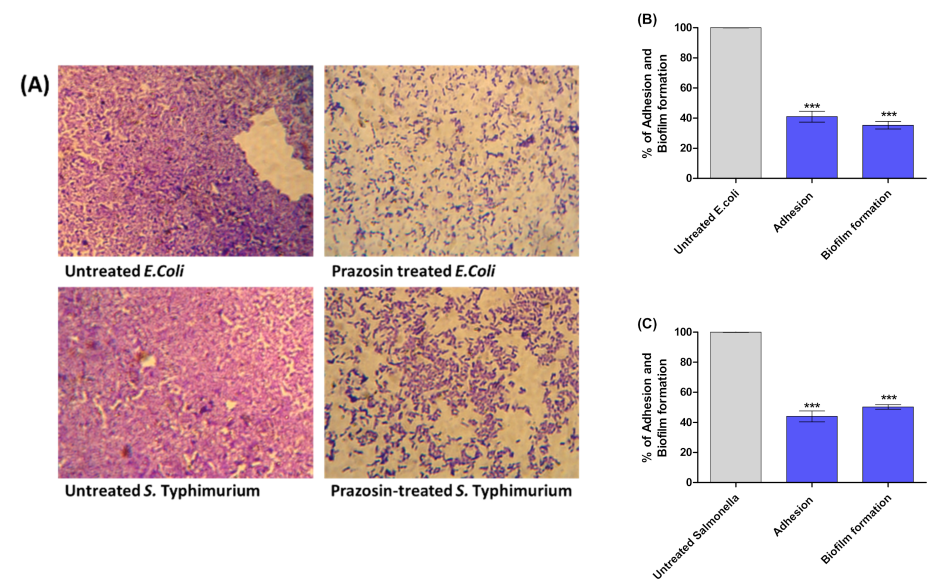
Figure 4. Prazosin diminished bacterial adhesion and biofilm formation. ( A ) Light microscope images represent the anti-biofilm activity of prazosin at sub − MIC. The crystal violet method was employed to evaluate bacterial adhesion and biofilm formation. The percent change in adhered and biofilm-forming ( B ) E. coli and ( C ) S. Typhimurium was significantly reduced in the presence of prazosin at sub − MIC (*** = p <